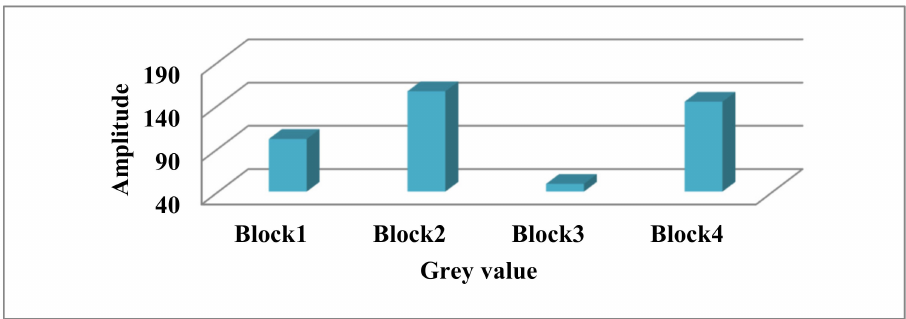
Figure 9. Contrast of respective blocks. Step 5 : Based on the contrast, the direction of histogram shifting is determined using Equation (3) and displayed in Figure 10. Figure 10 shows dynamic data embedding on either side of the peak. The sub-steps are defined